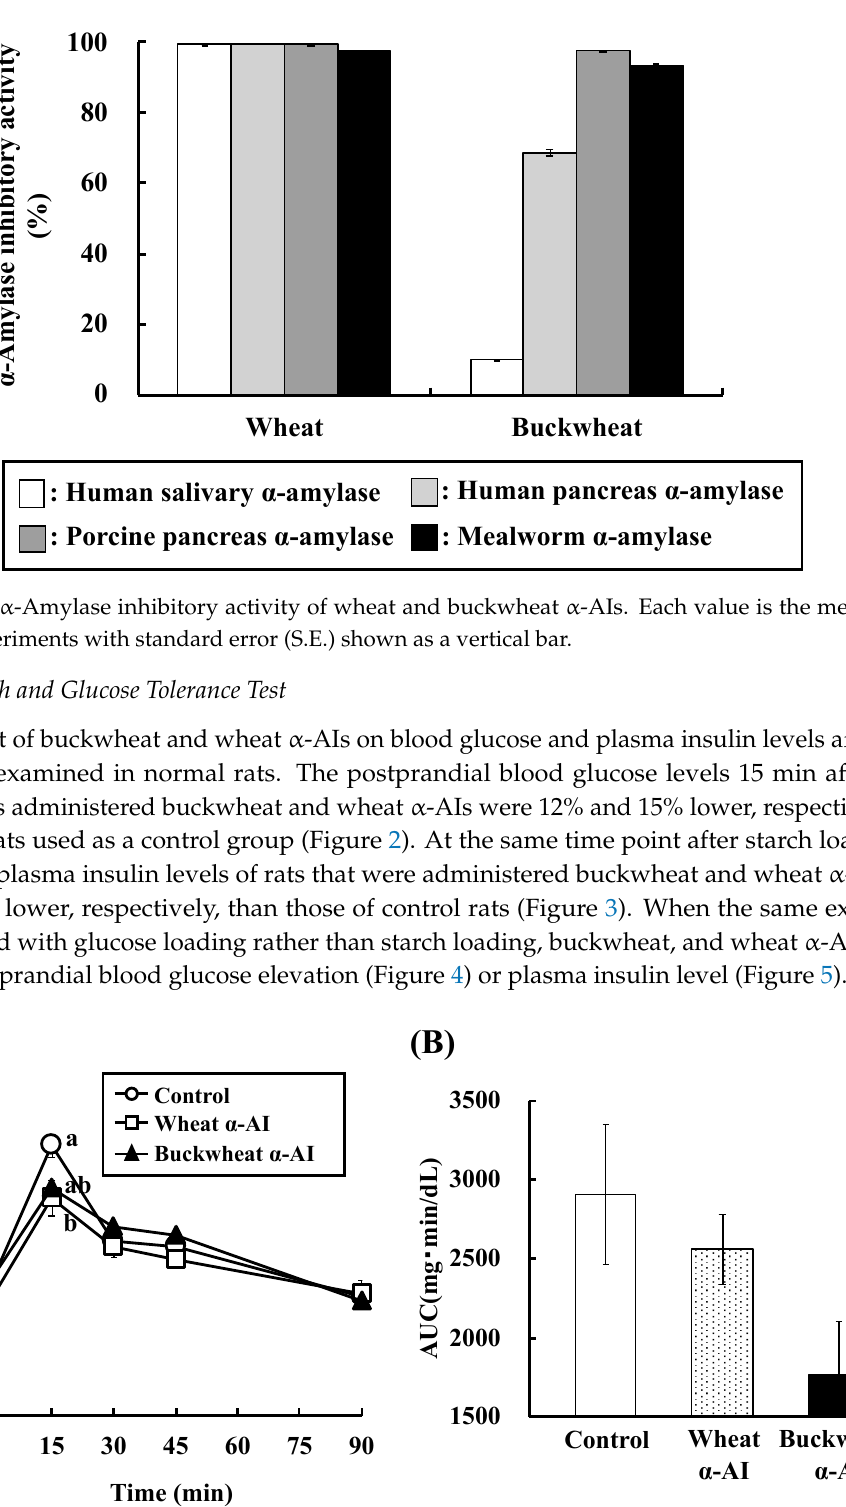
Figure 2. Effect of wheat and buckwheat α -amylase inhibitors ( α -AIs) on ( A ) blood glucose level and ( B ) glucose area under the curve (AUC) after oral starch tolerance test using Wistar rats. Each value is the mean of 6–7 experiments with S.E. shown as a vertical bar. Values with different letters are significantly different at p < 0.05.